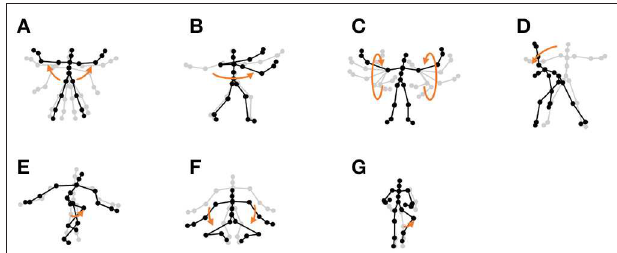
FIGURE 12 | Seven unit motions included in exercise motion 1: (A) jumping jack, (B) twist, (C) arm circle, (D) bend over, (E) knee raise, (F) squatting, and (G)